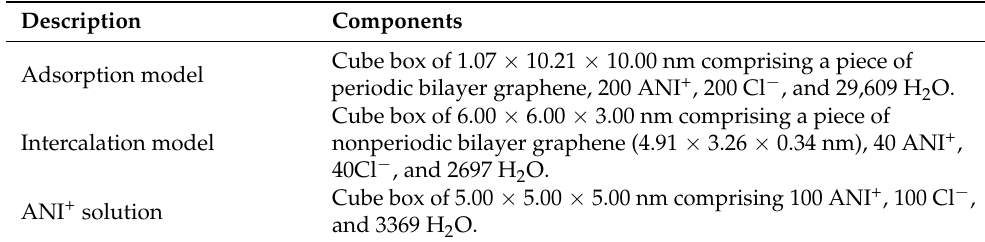
Table 1. Descriptions of models for MD